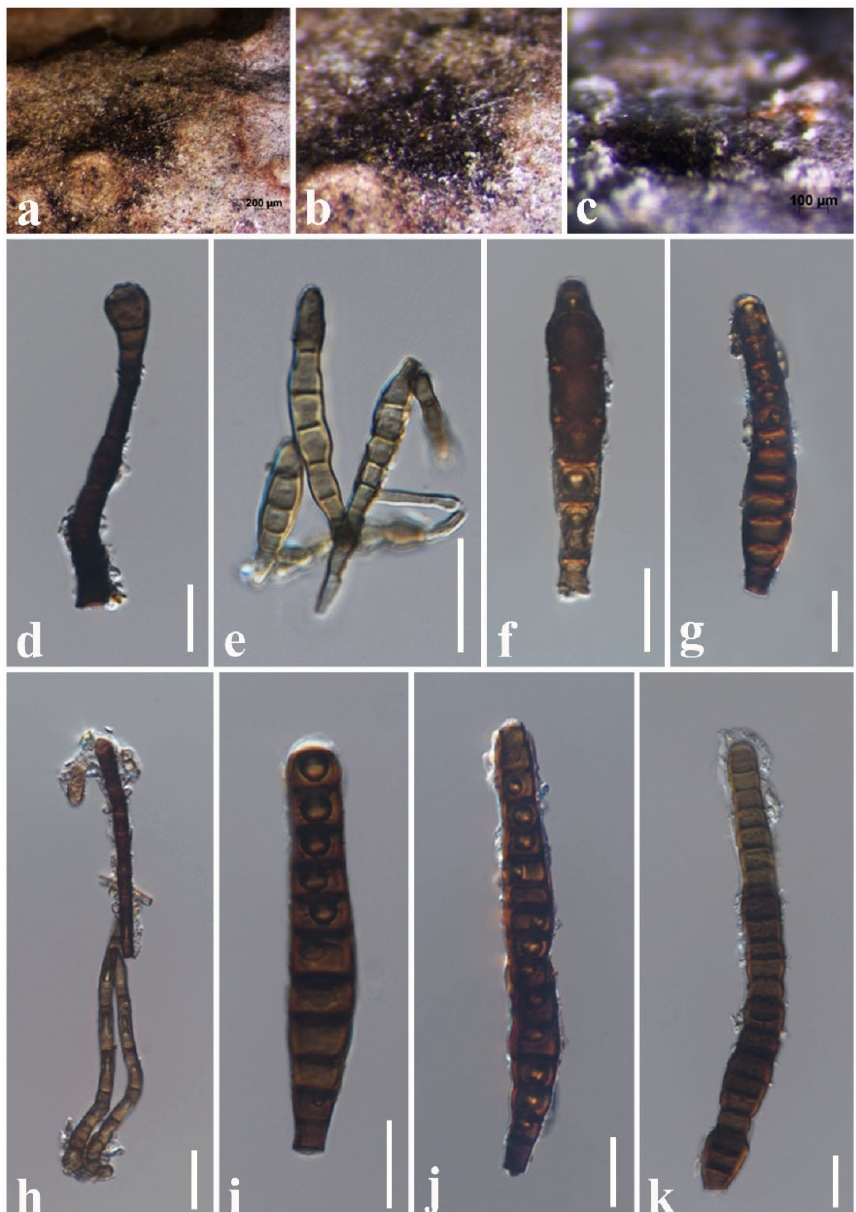
Figure 11. Kirschsteiniothelia thailandica (HKAS 107110, new host record). ( a – c ) Colonies on natural substrate. ( d ) Conidiophore and Conidiogenous cell. ( e – g ) Conidia. ( h ) Conidiophores. ( i – k ) Conidia. Scale bars: ( c ) = 100 μ m, ( d – k ) = 20 μ m.